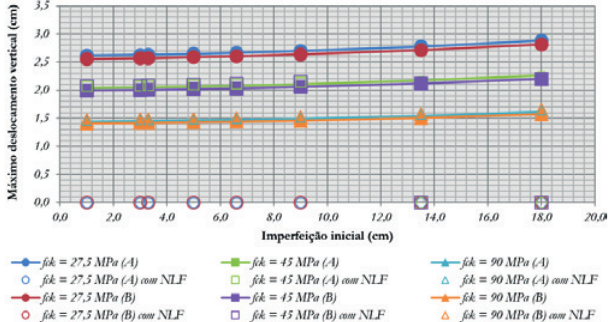
Figura 11 Máximos deslocamentos verticais com análise não linear física Fonte: Autores (2017)